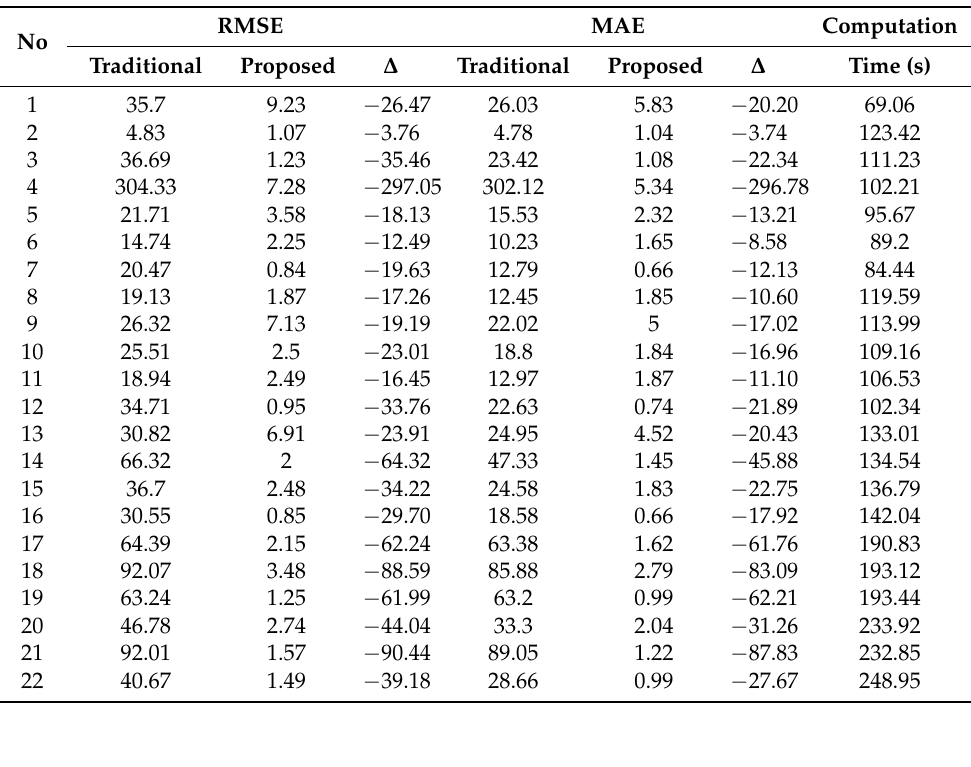
Table 7. Performance comparison for long-term solar power forecasting by the models.